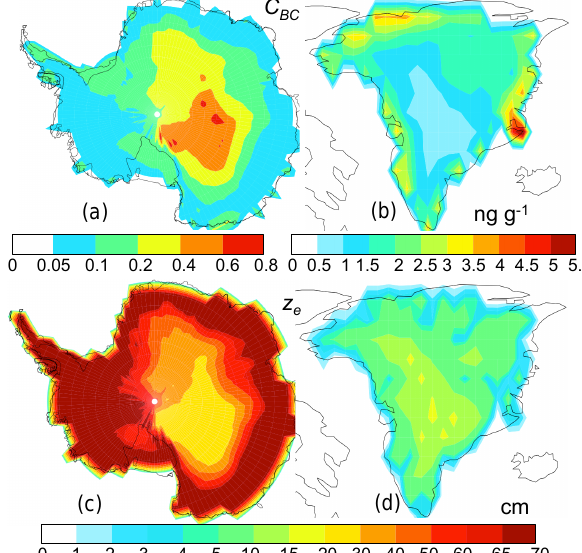
Figure 3. (a, b) Modeled annual mean snow black carbon concen- trations ( C BC ) . (c, d) Calculated mean summer (DJF, Antarctica; JJA, Greenland) UV e -folding depth ( z e ) .